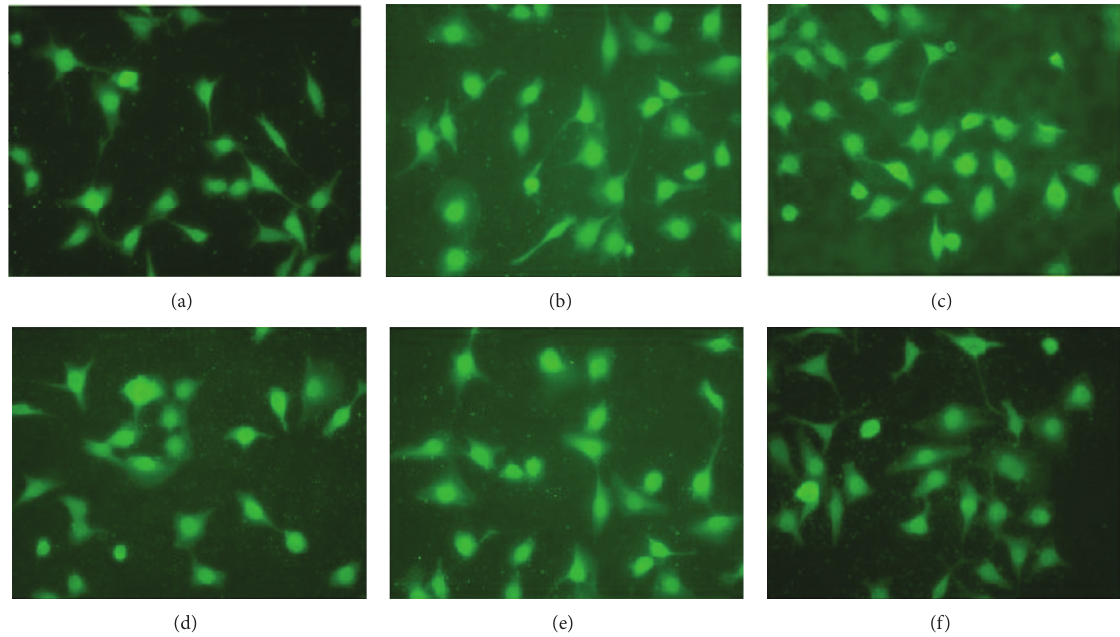
Figure 8: Immunofluorescence studies of EM2 on p38 MAPK in HUVECs. Cells were fixed and incubated with p38 MAPK antibody and a FITC-conjugated second antibody. Pictures were taken at 400x magnification. ((a) AGEs-BSA, (b) BSA, (c) 10 𝜇 M, (d) 1 𝜇 M, (e) 0.1 𝜇 M, (f)